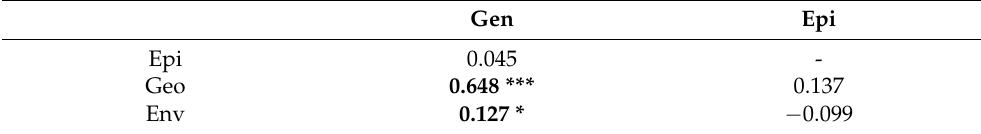
Table 5. Partial Mantel tests were conducted to compare the relative effects of environment and spatial distance on genetics and